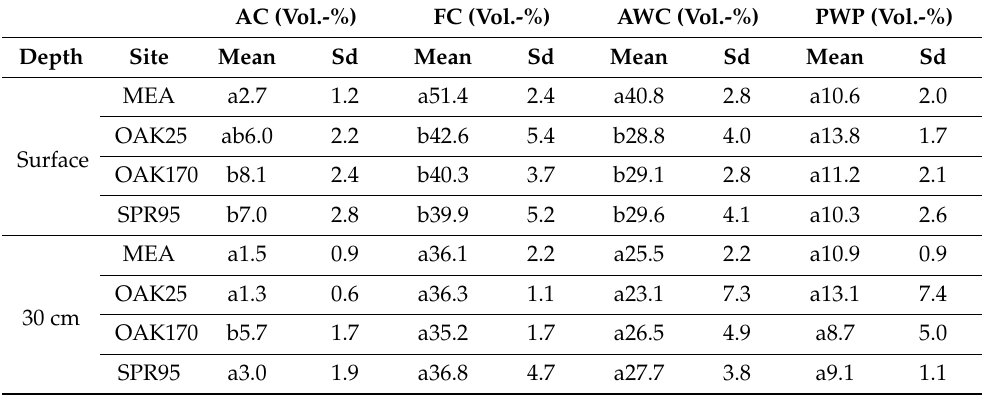
Table 3. Volume fractions for air capacity (AC) ( θ between pF0 and pF1.8), field capacity (FC) (